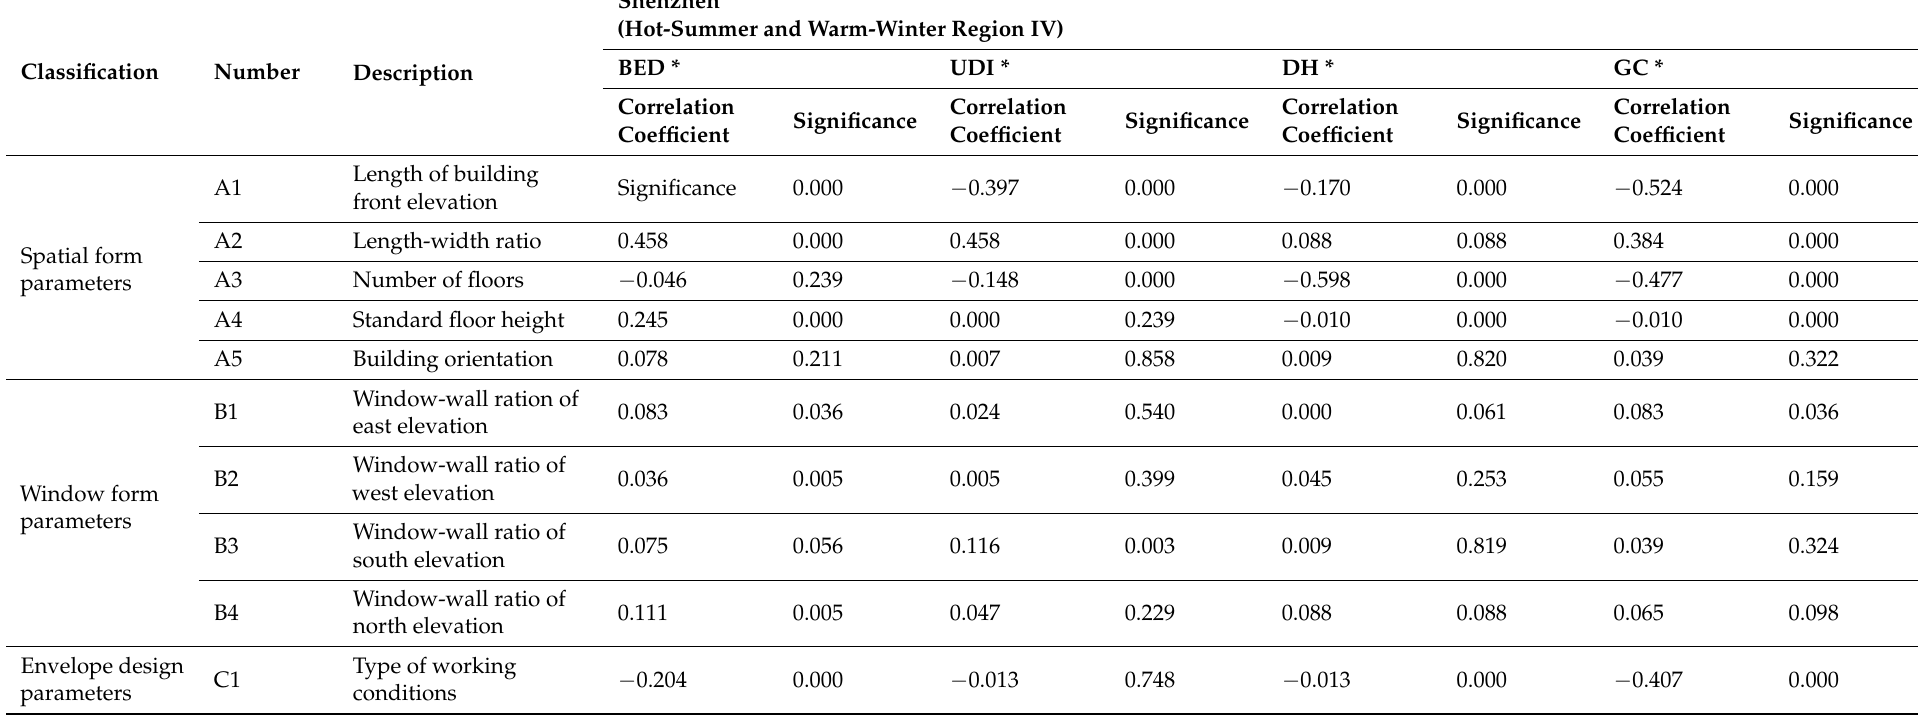
Table 11. Comparison of Spearman’s rank correlation coefficient of the design parameters of building forms in